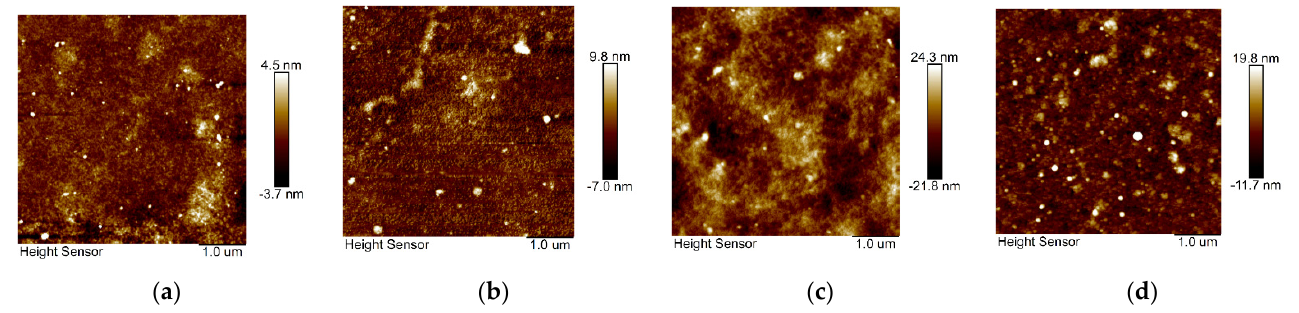
Figure 6. AFM height images of PIDT-BBT ( a ) pristine films and ( b ) films doped with F4TCNQ, PIDTT-BBT ( c ) pristine films and ( d ) films doped with F4TCNQ.